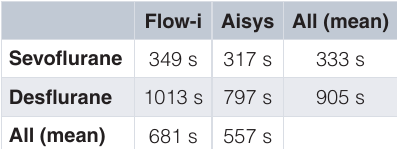
Table 1. Times at which wash-out plateaued, and fastest wash-out times at optimal flow rate.